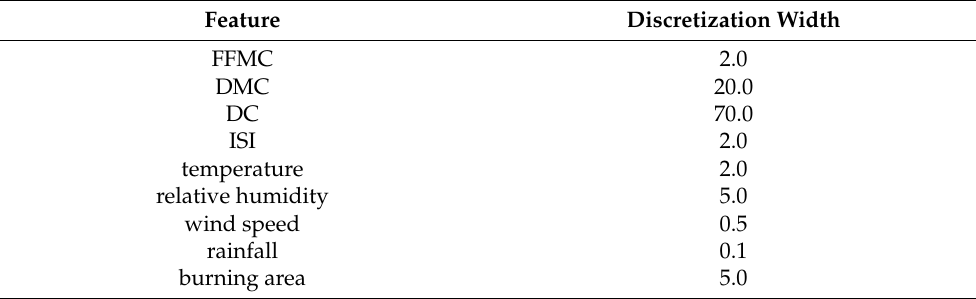
Table 4. Discrete intervals for each type of feature.